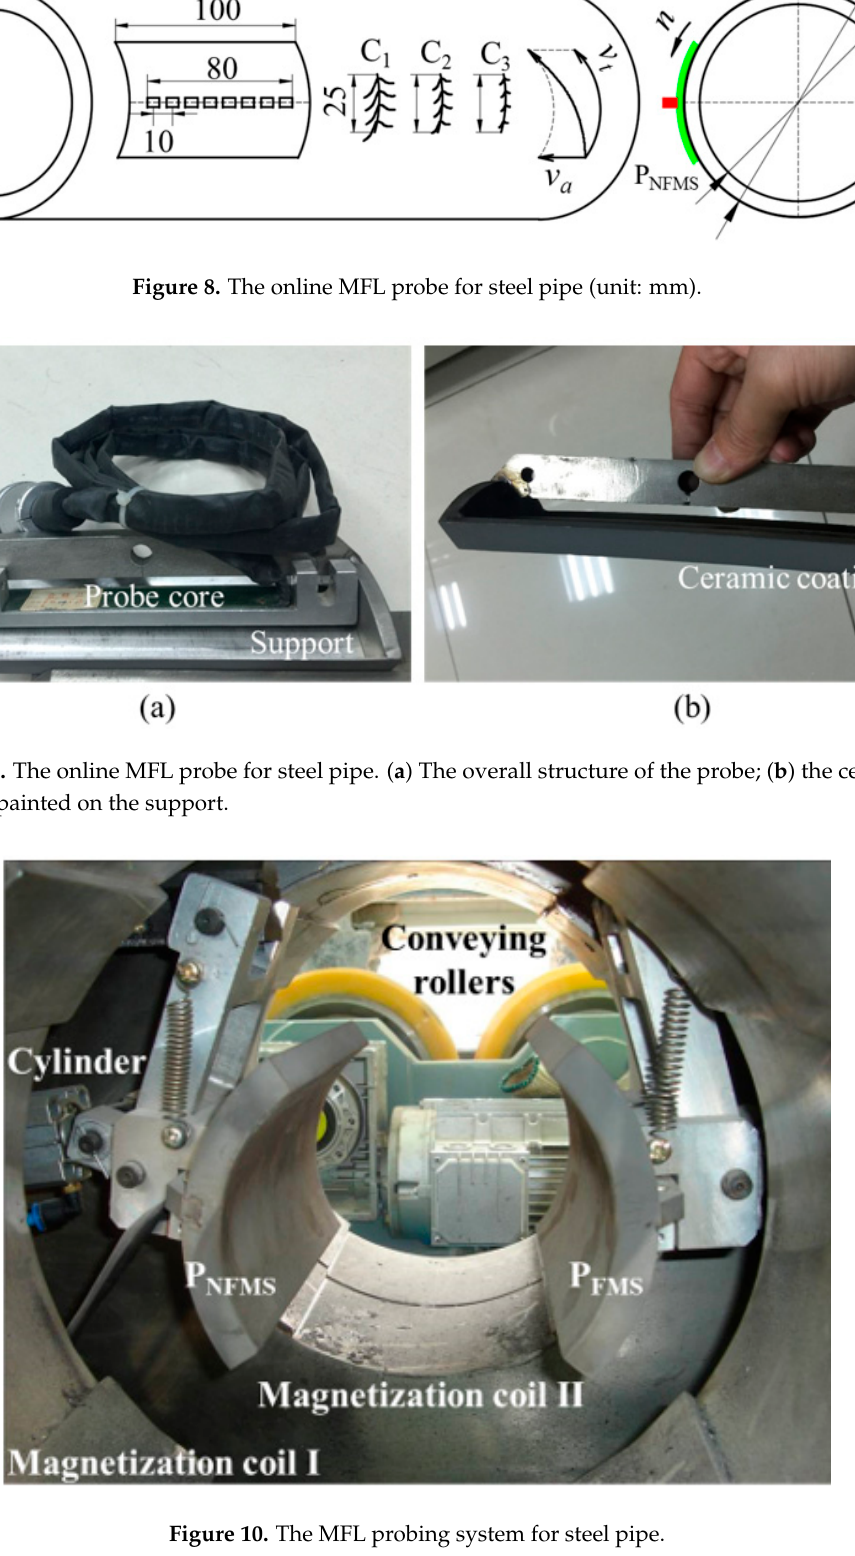
Figure 11. The whole online MFL inspection apparatus for steel pipe.